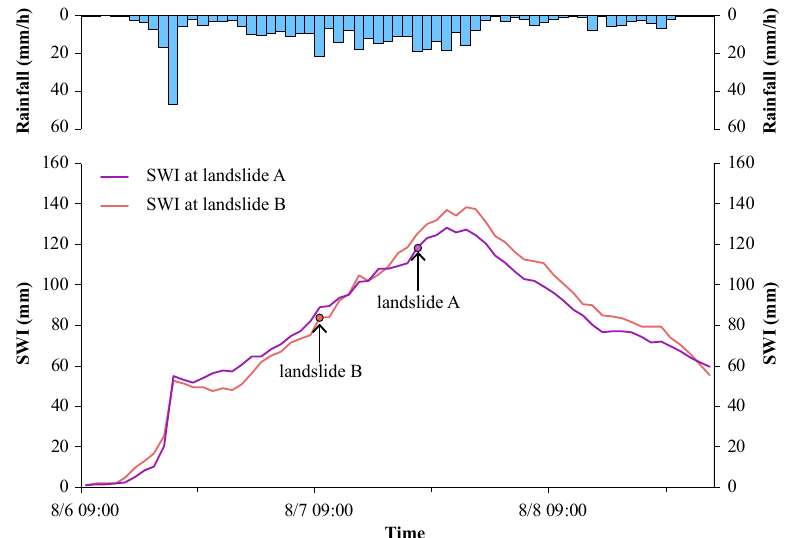
Figure 7. Hydrograph of the two curves of simulated soil water index (SWI) at two simulated landslides. For further discussion of the landslide A and B, refer to the following section and Figure 6a.